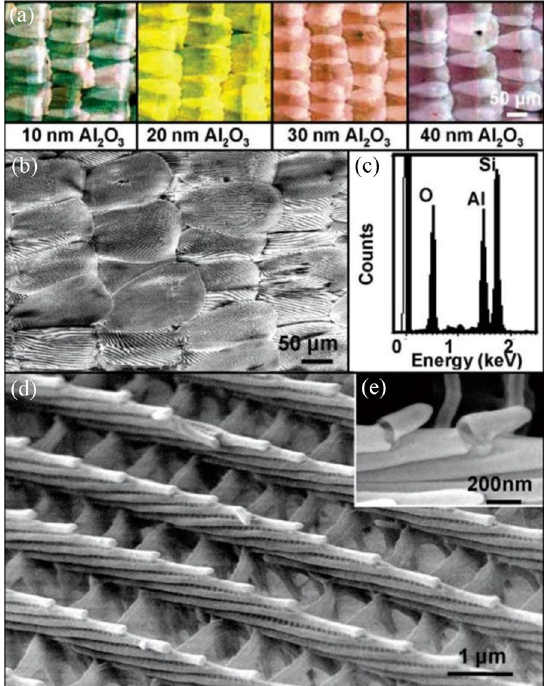
Figure 9 An image of butterfly wing scales reproduced in alumina: a Optical microscope image of aluminum-coated butterfly wing scales; b Low-magnification SEM image of the aluminum oxide replica of butterfly wing scales; c Energy dispersive X-ray (EDX) spectrum of the alumina replica shown in b ; d High magnification SEM image of alumina replica; e SEM image of two broken rib tips on alumina replica [63]